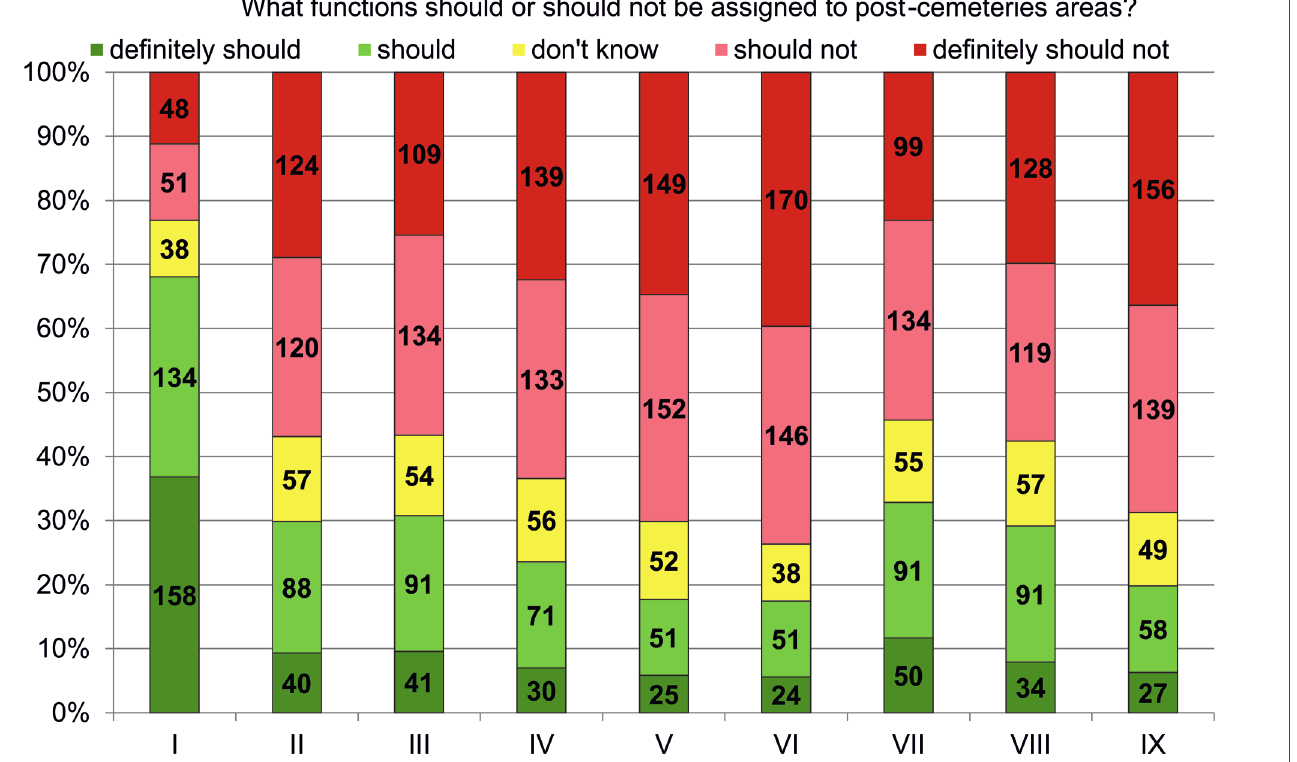
Figure 17. New functions of post-cemetery areas and their social